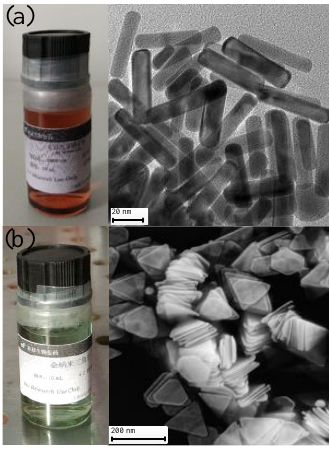
Figure 8. SEM image of GNR and GNT solutions. ( a ) GNRs; ( b ) GNTs.